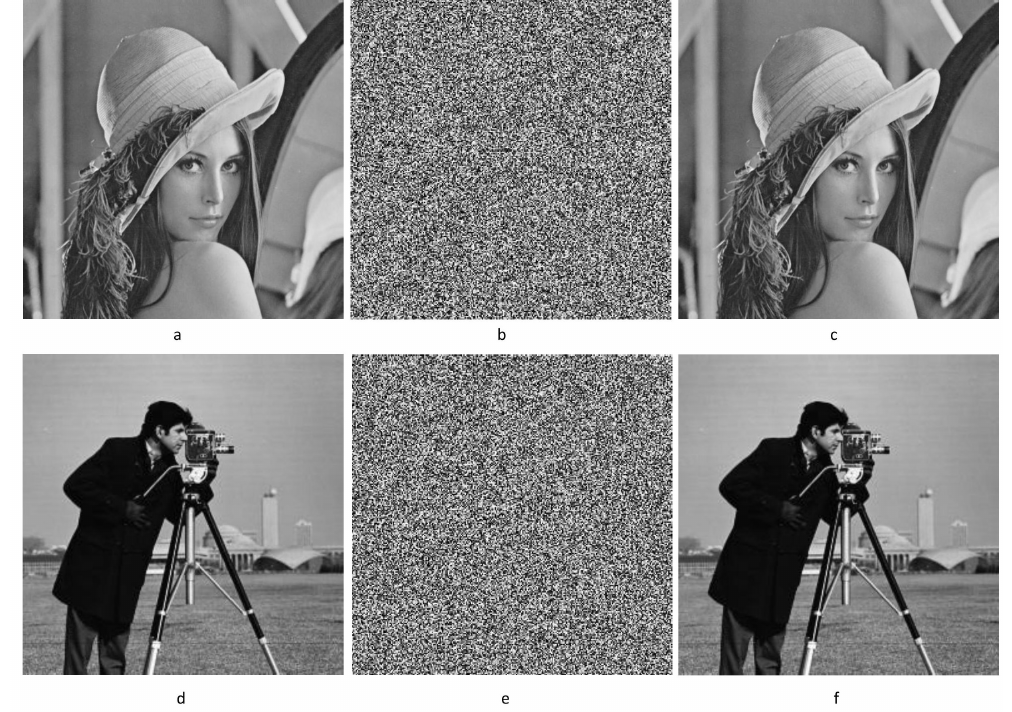
Figure 10. Simulation results. ( a – c ) are original image, encrypted image, and decrypted image of Lena, respectively. ( d – f ) are original image, encrypted image, and decrypted image of Cameraman,